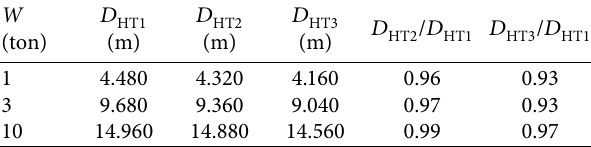
Table 9: Crater dimensions according to the hydrotensile limit.